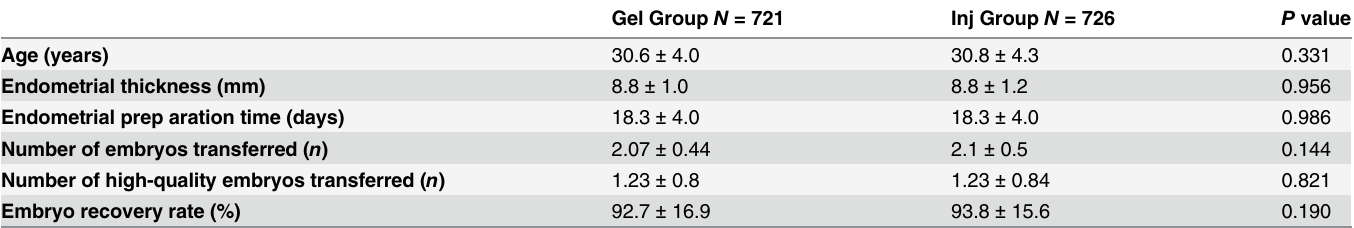
Table 1. Comparison of the baseline characteristics of the patients included in the analysis. Data are presented as the mean ± standard